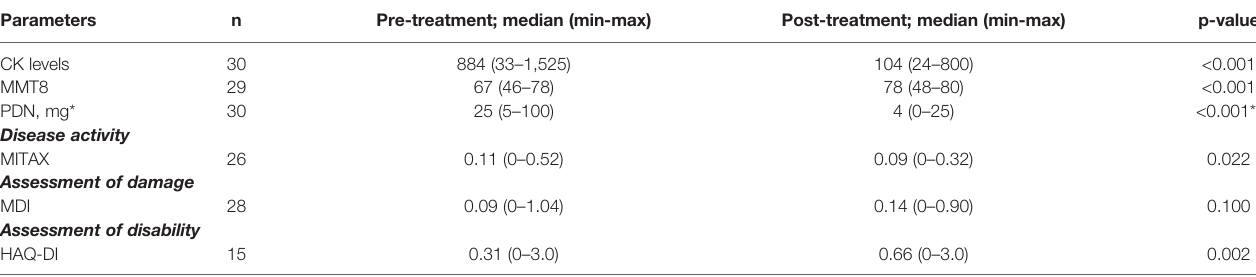
TABLE 2 | Selected parameters before and after 20% SCIg treatment in patients with PM and DM.